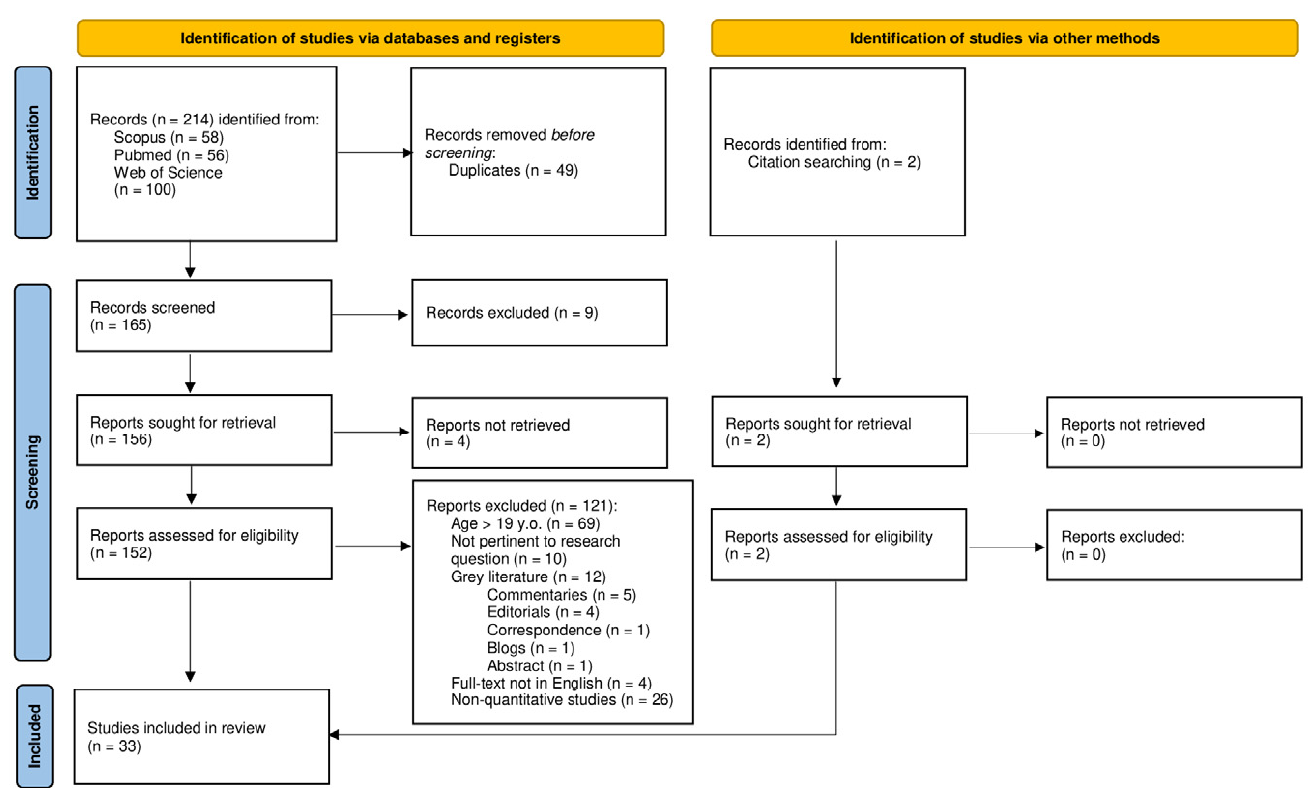
Figure 1. PRISMA 2020 flow diagram. From: Page MJ, McKenzie JE, Bossuyt PM, Boutron I, Hoffmann TC, Mulrow CD, et al. The PRISMA 2020 statement: an updated guideline for reporting systematic reviews. BMJ 2021;372:n71. doi: 10.1136/bmj.n71 [52]. For more information, visit: http://www.prisma-statement.org/ (accessed on 23 November